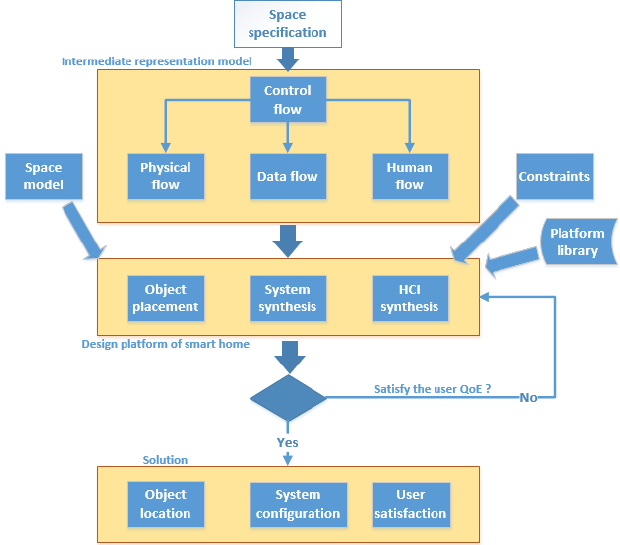
Figure 10. The design framework for sensing home.